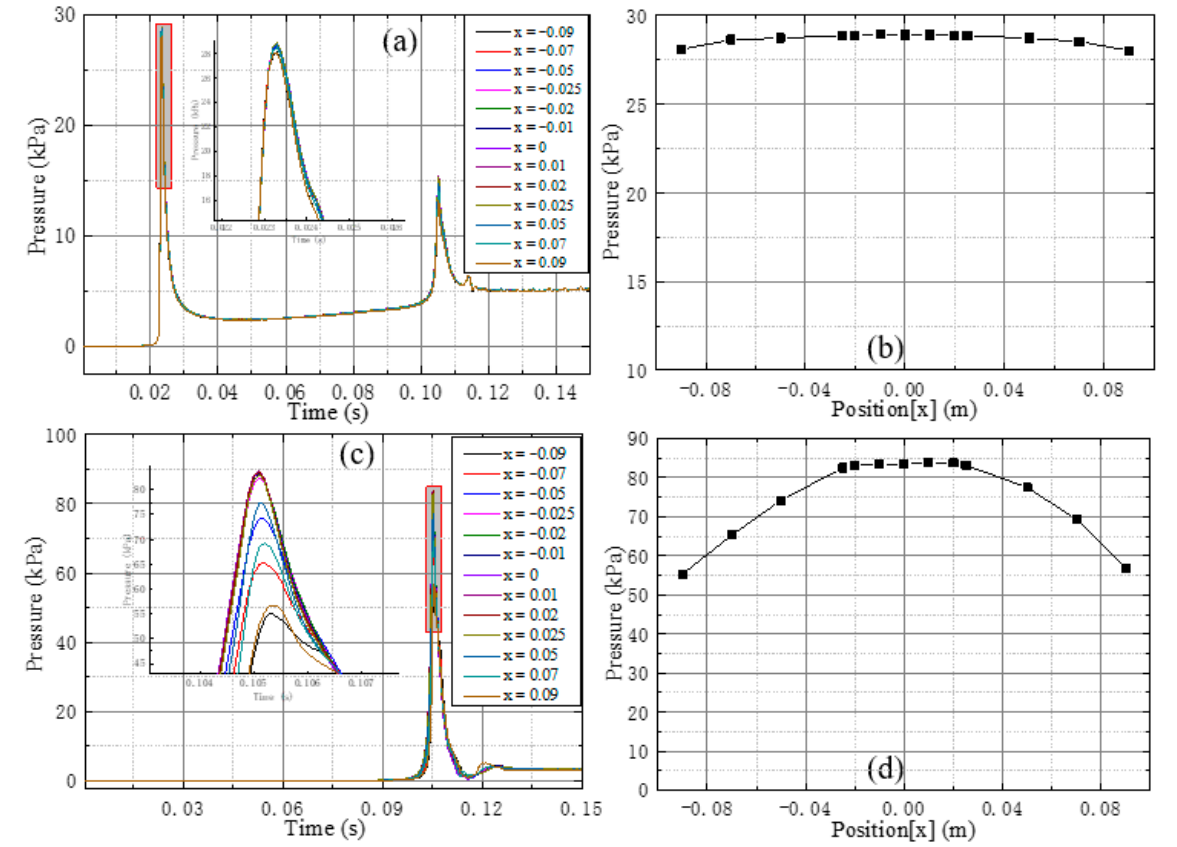
Figure 4. The pressure time histories at different monitoring pointes along the X direction and the corresponding peak pressures (( a , c ): pressure time histories of monitoring points under main hull p1 and wet-deck p4, respectively, along the X direction in Figure 1b; ( b , d ): the peak pressures at p1 and p4 vs. X-coordinates, respectively).